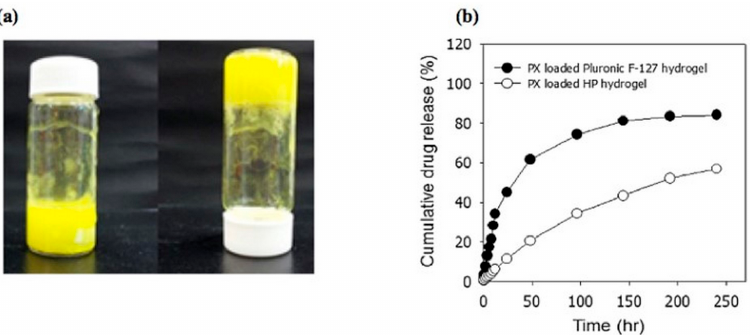
Figure 9. Photographs of the hydrogel ( a ) and in vitro Paclitaxel release from Pluronic F-127 and Pluronic F-127 / HA-based hydrogels ( b ) [67]. Reproduced with permission from Elsevier, 2016.